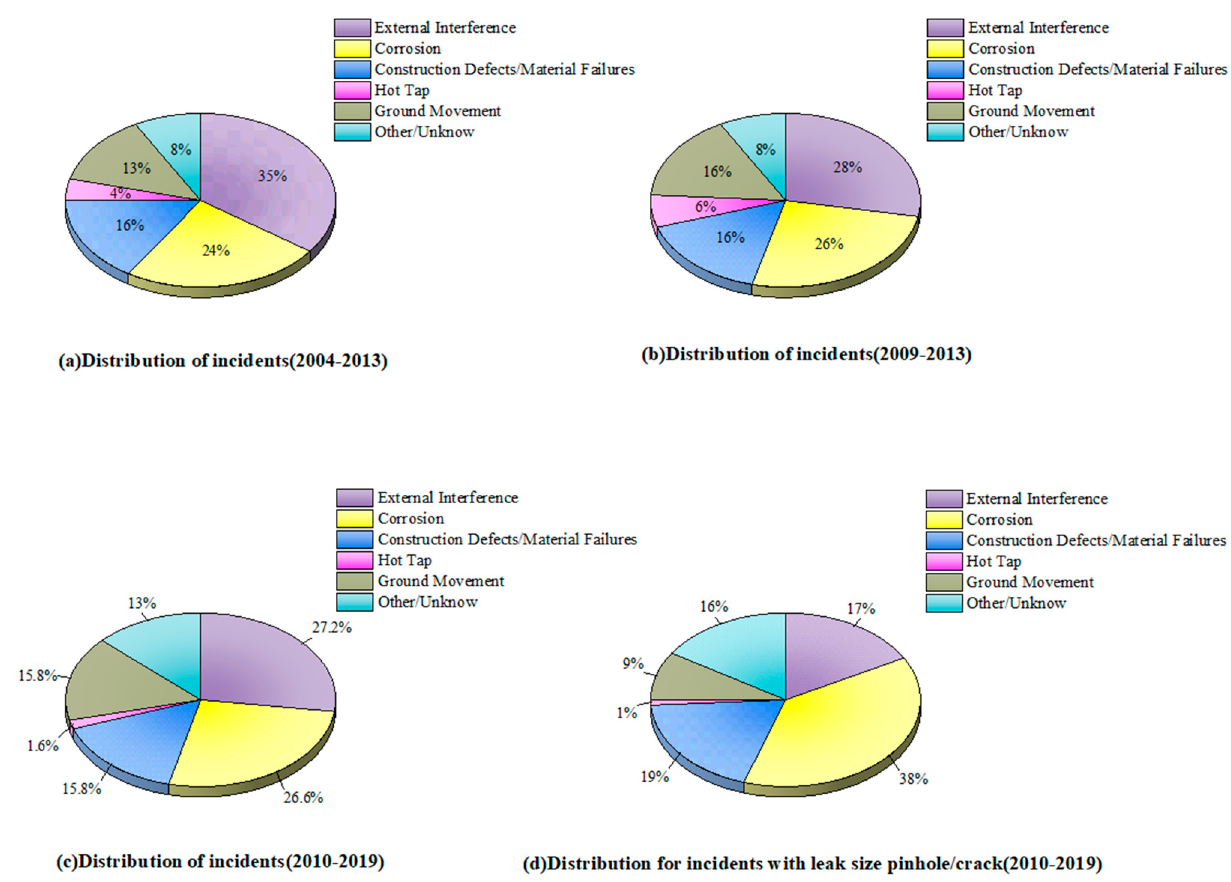
Figure 1. Distribution of incidents: ( a ) 2004–2013; ( b ) 2009–2013; ( c ) 2010–2019; ( d ) with leak size pinhole/crack (2010–2019).